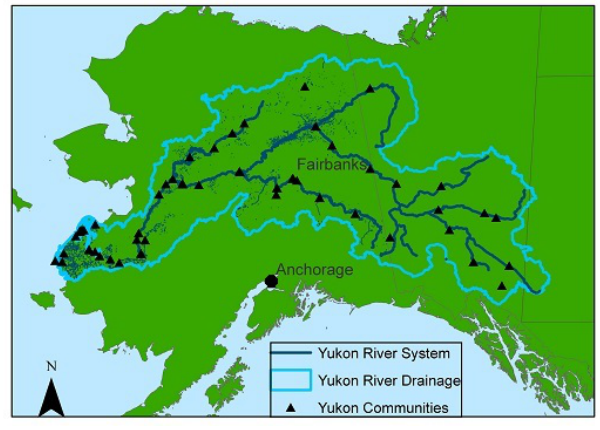
Fig. 4 . Map of the Yukon River Drainage and